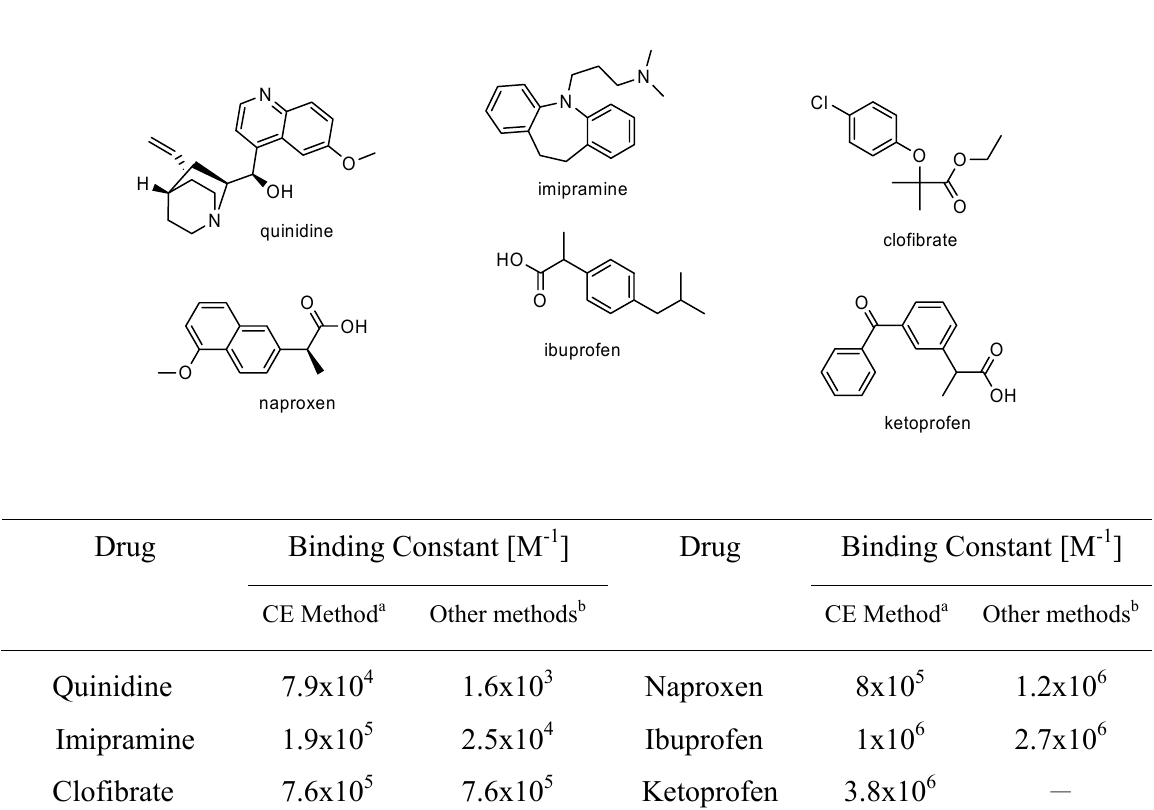
Table 1 : Binding constants of drugs to HSA